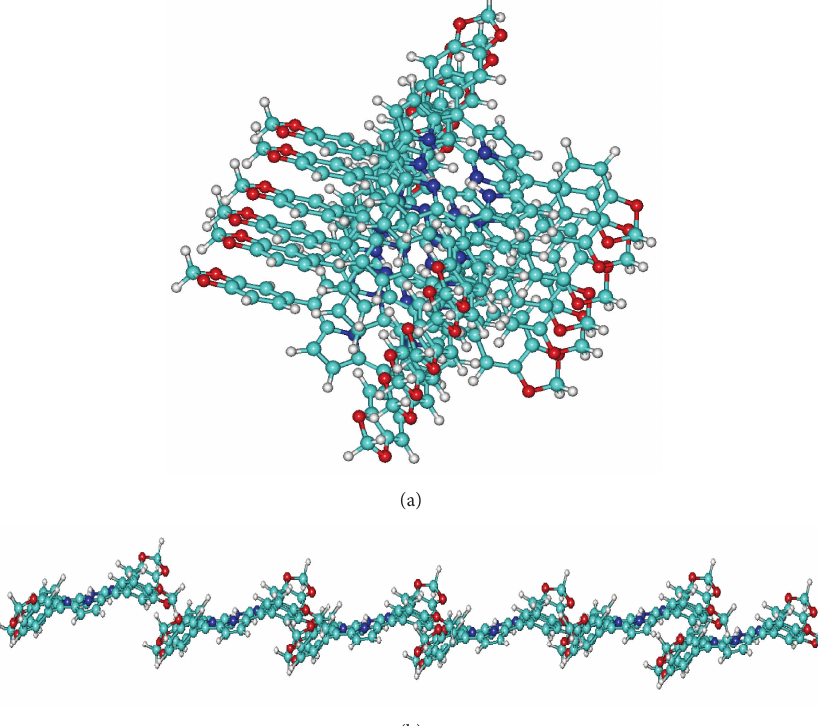
Figure 1: Face-to-face (a) versus side-by-side (b) aggregates displayed on 5,10,15,20-meso-tetrakis-(3,4-methylenedyoxy)-phenyl-21,23H